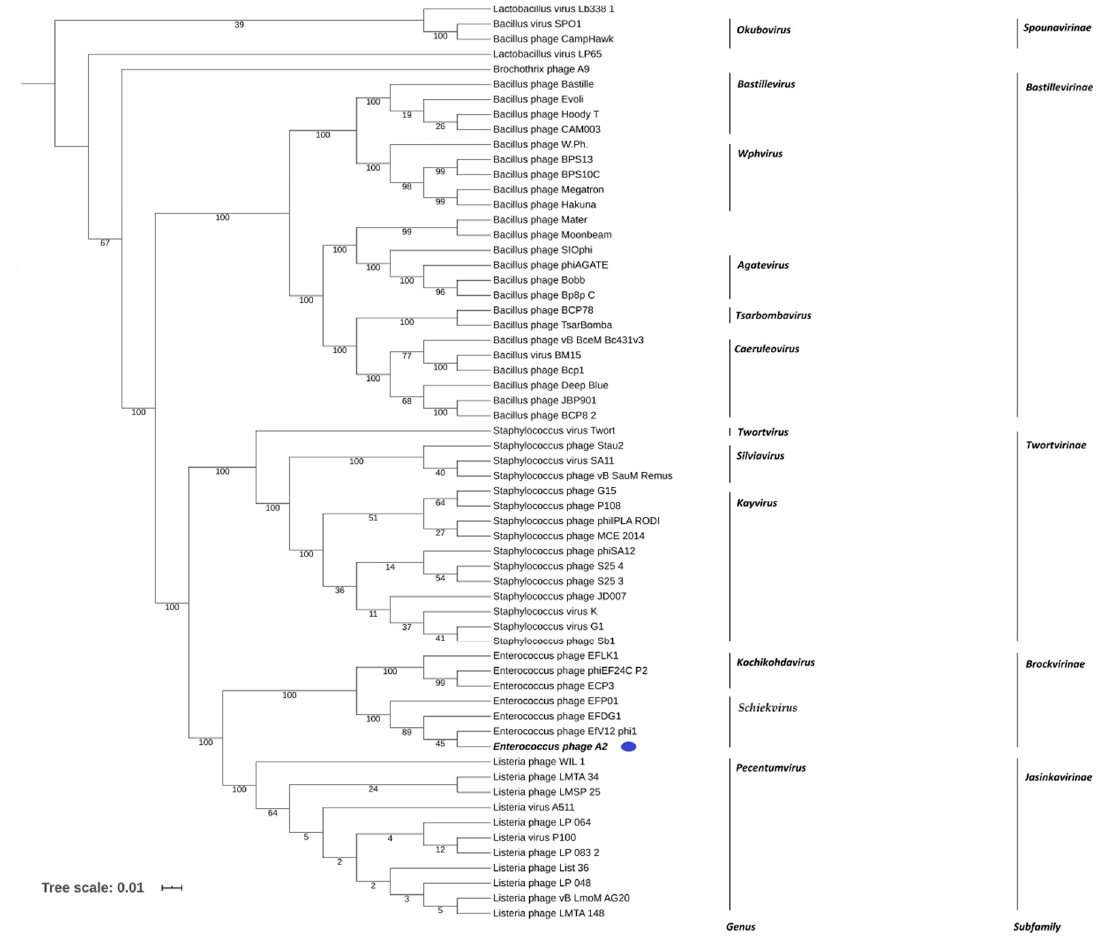
Figure 3. Amino acid based VICTOR-generated phylogenomic Genome-BLAST Distance Phylogeny (GBDP) tree of Enterococcus phages A2 (highlighted with a blue dot), EfV12-phi, and EFP01 with 58 members of the Herelleviridea family Inferred using the formula D4 and yielding average support of 69%. The numbers below branches are GBDP pseudo-bootstrap support values from 100 replications.